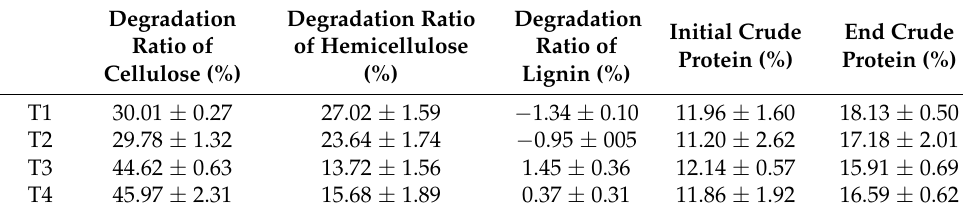
Table 3. Utilization efficiency of each component in different